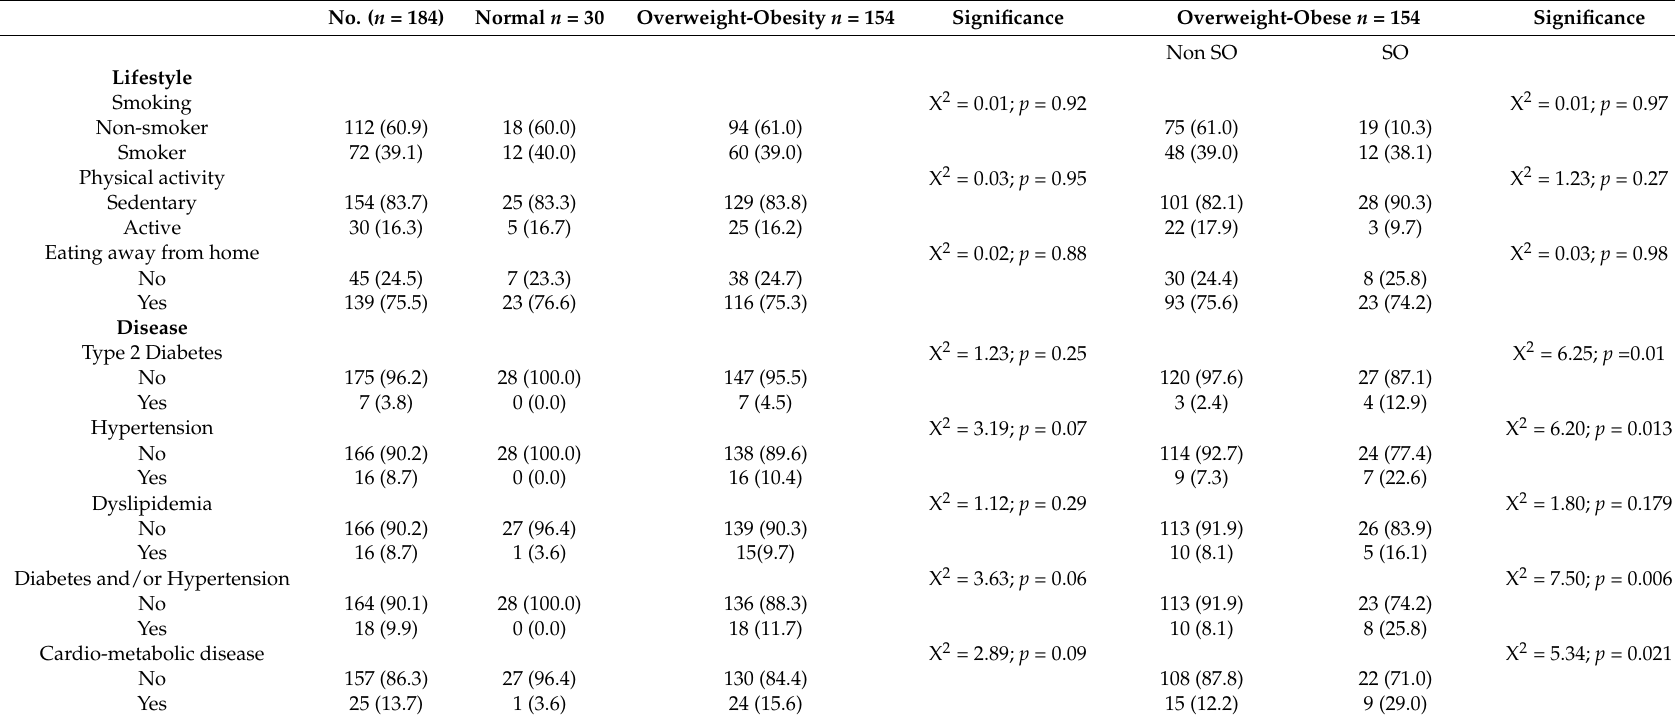
Table 1. Socio-demographic, lifestyle, and health characteristics of the study